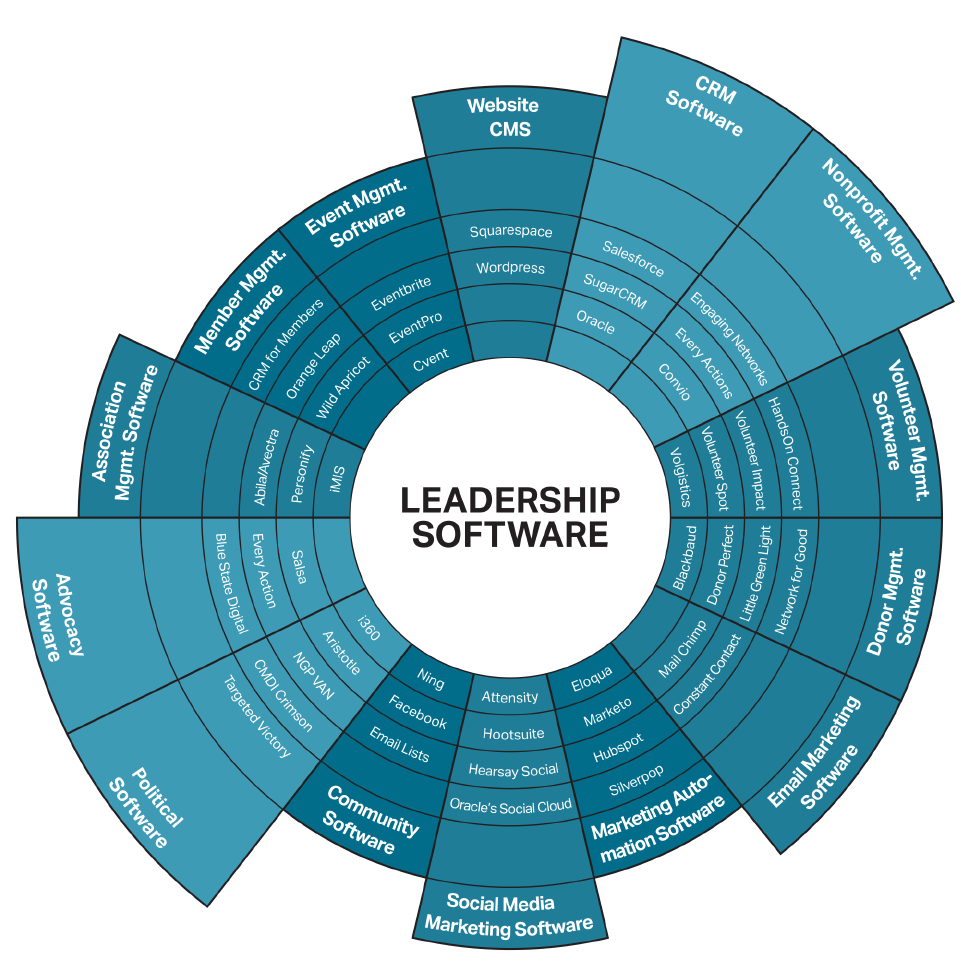
Figure 1: Political technology firms according to